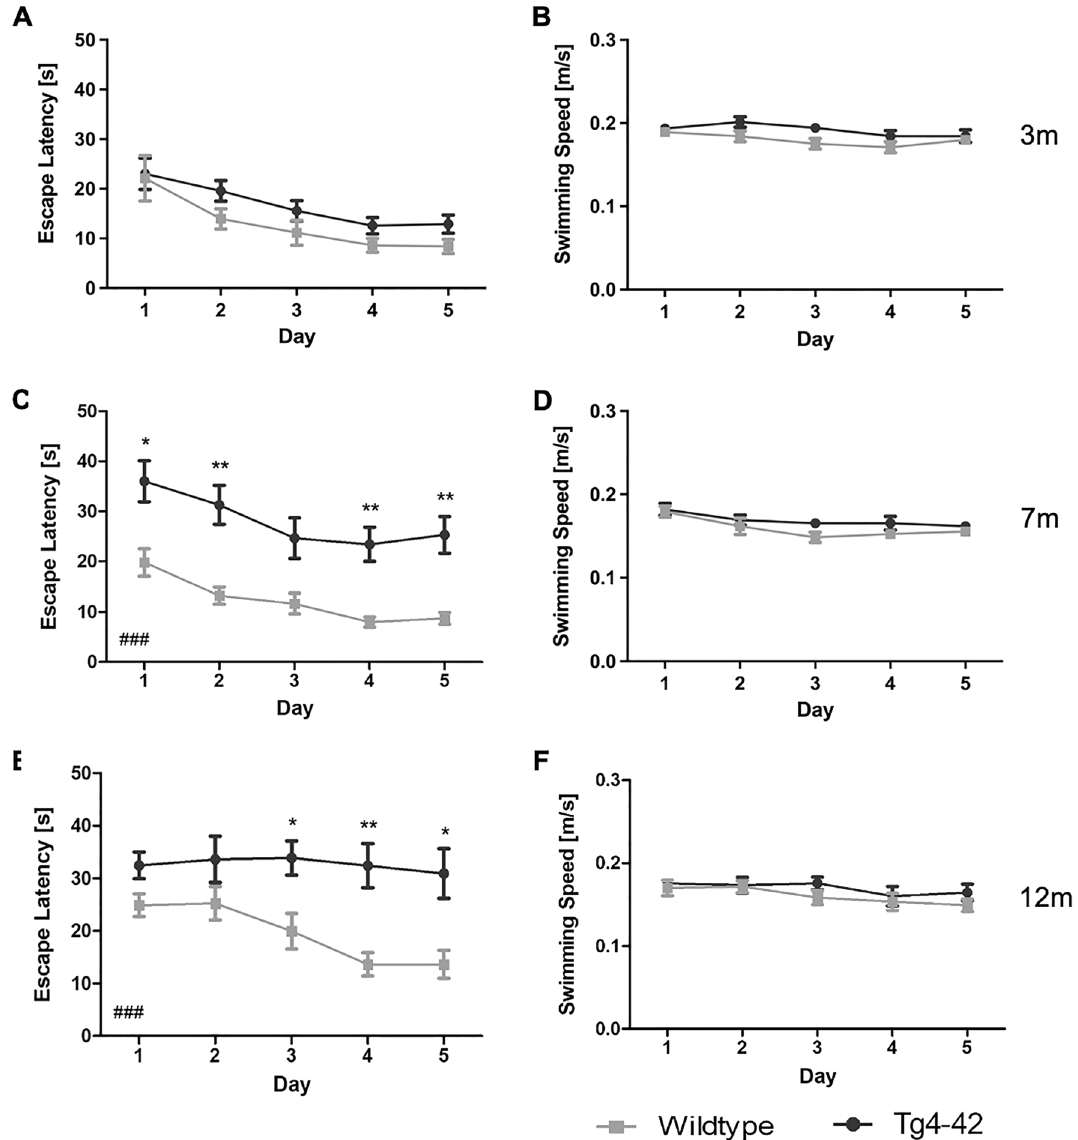
Figure 2. Tg4-42 mice display age-related spatial learning deficits in the acquisition training. Homozygous female Tg4-42- and WT mice were tested at 3m ( A , B ), 7m ( C , D ) and 12m ( E – F ). At 3m, escape latencies did not differ significantly between Tg4-42 and WT mice ( A ). In contrast, 7m ( C ) and 12m ( E ) Tg4-42 mice required significantly more time to reach the goal platform than same-aged WT mice. Swimming speed ( B , D , F ) did not differ between Tg4-42 and WT animals independent of age. Two-way repeated measures ANOVA followed by Bonferroni multiple comparisons; n = 9–14. All Data presented as mean ± S.E.M. ANOVA: ### p < 0.001; Bonferroni: * p < 0.05, ** p < 0.01, *** p <